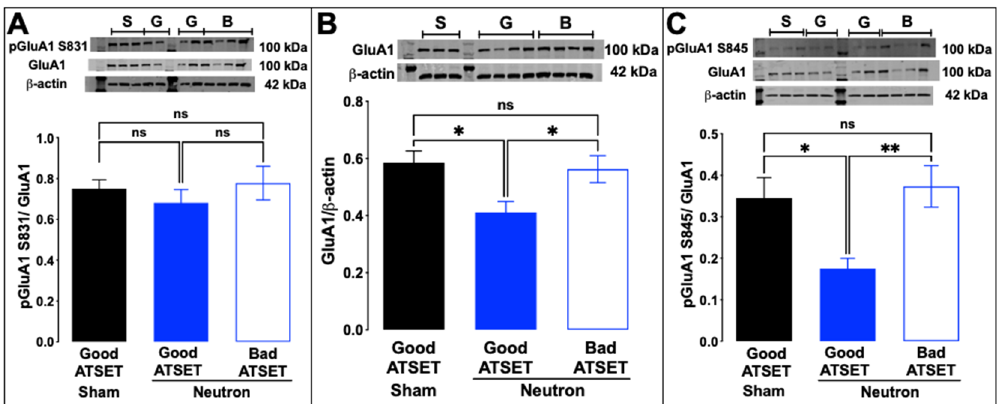
Figure 8. Phosphorylation of serine at position 845 of the GluA1 subunit is significantly decreased in good ATSET rats. ( A ) The phosphorylation state of the serine residue at position 831 was not altered, but ( C ) at position 845, the good ATSET group showed lower phosphorylation of serine compared to the other two groups. ( B ) Interestingly, significantly lower expression of GluA1 subunit of the AMPA receptors was noted in the good ATSET neutron rats compared to the other two groups. Crude synaptosomal fractions from three-four animals per group were used in the assessment and statistical significance (* p < 0.05, ** p < 0.01) was determined using non-parametric, Kruskal–Wallis t-test.